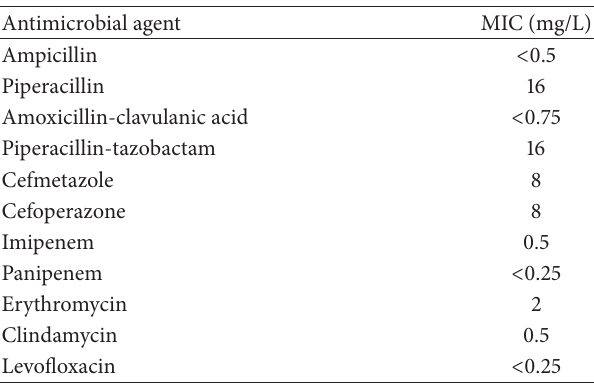
Table 1: The results of antimicrobial susceptibility